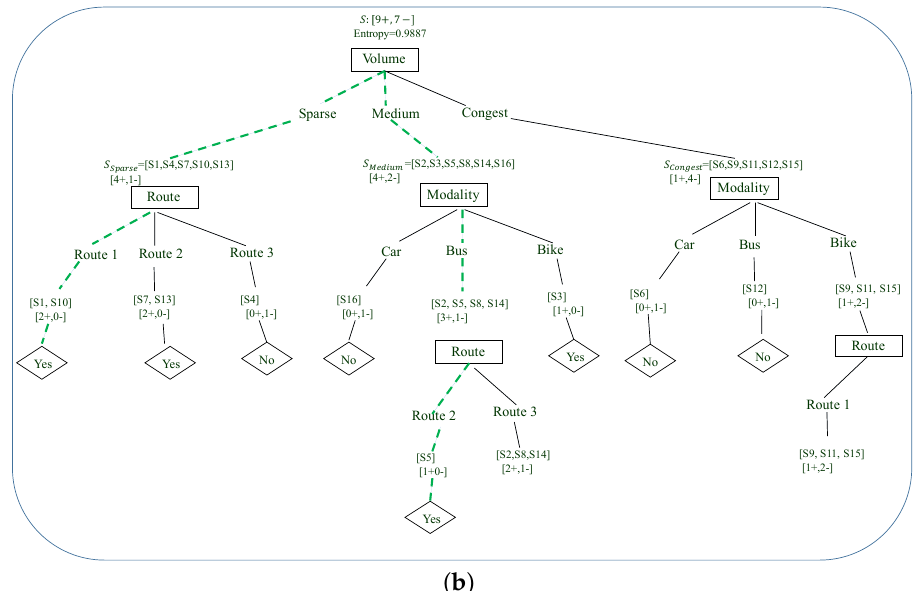
Figure 3. ID3 is used to build the incentive decision tree according to the sample data for group S (Step